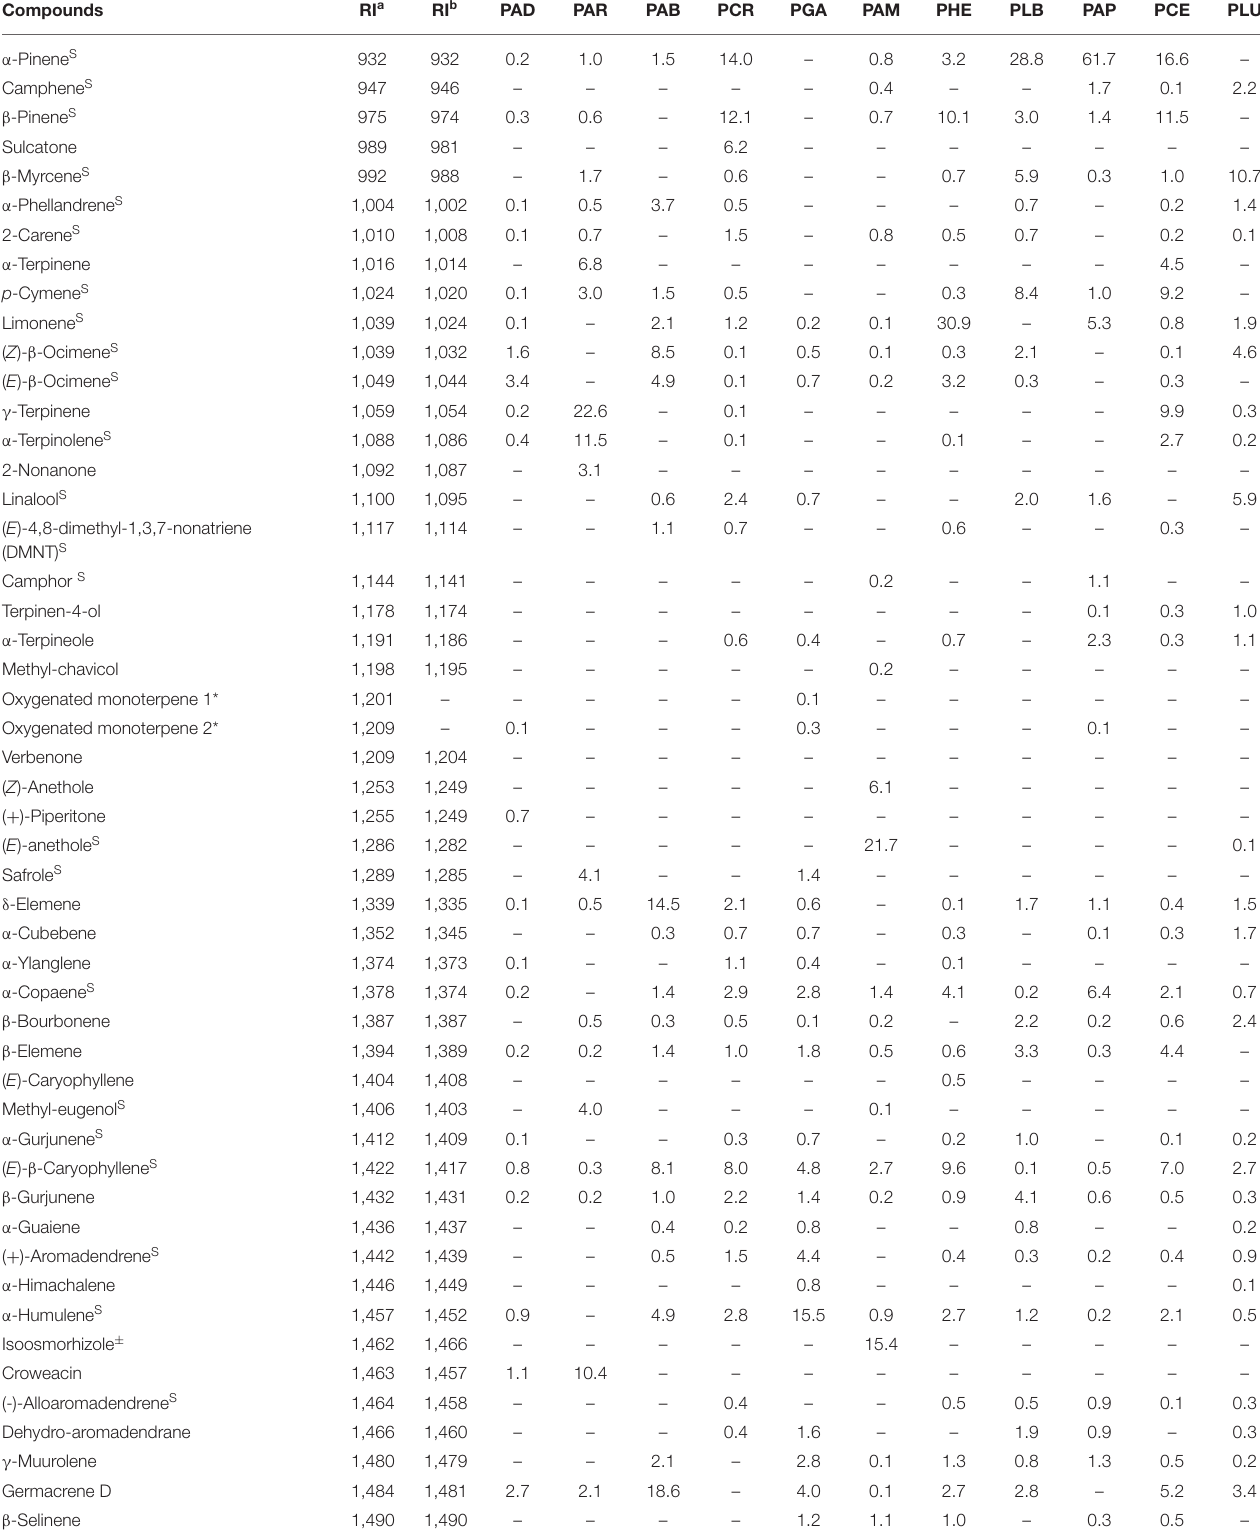
TABLE 6 | Chemical composition of the essential oils of Piper species.